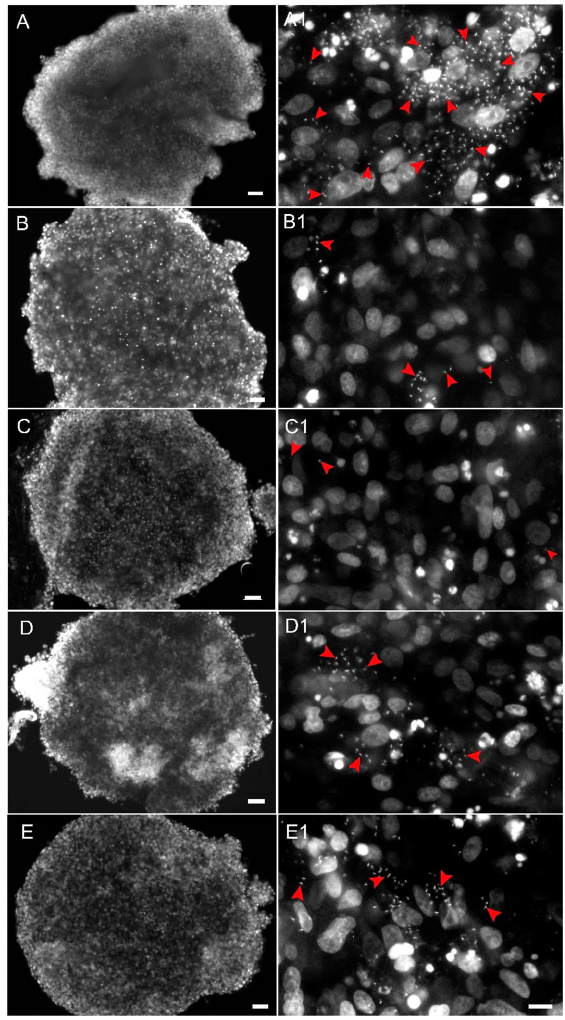
Figure 6. Analysis of 2c , 2e , and 2i efficacy on T. cruzi -infected microtissues. ( A – E ) DAPI staining images of the whole infected spheroids untreated ( A ) and treated with Bz ( B ), 2c ( C ), 2e ( D ), and 2i ( E ). ( A1 – E1 ) Representative areas of infected microtissues, highlighting the nucleus of the host cells, and the nucleus and kinetoplast of intracellular amastigotes (red arrowhead). ( A1 ) Large amounts of intracellular amastigotes (red arrowhead) are visualized in T. cruzi ‐ infected microtissue without treatment (control). ( B1 ) Bz treatment (100 μ M) showed a drastic reduction in the infection profile, with few intracellular parasites (red arrowhead). ( C1 ) Treatment with 2c (50 μ M) showed a similar effect to Bz with rare parasites. Treatment with 2e ( D1 ) and 2i ( E1 ) at 100 μ M concentration also revealed a reduction in parasite load. Bars: 50 μ m ( A – E ) and 10 μ m ( A1 – E1 ). 3.6. Potential of Pyrazole ‐ Thiazoline Derivatives to Prevent Parasite Resurgence and the Effect in Combination Therapy An important issue was to assess the compound activity reversibility. Then, the se ‐ lected candidates ( 2c , 2e , and 2i ) were evaluated for a prolonged period of time in order